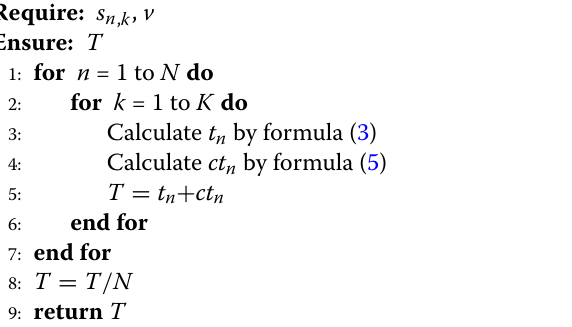
Algorithm 1 The Average Time of Data Transmission